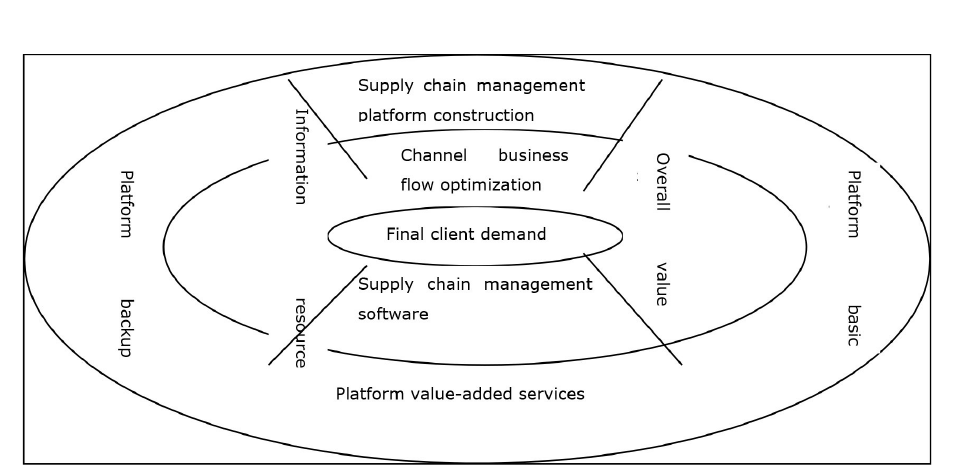
Figure 1. Collaborative management of supply